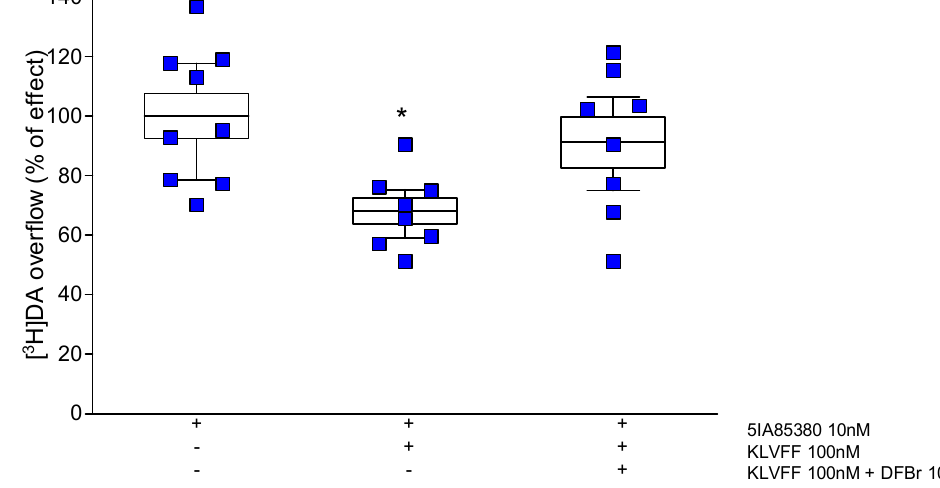
Figure 7. Effect of DFBr on the KLVFF modulation of 5IA85380-induced [ 3 H] dopamine overflow from striatal synaptosomes. Data are mean ± SEM ( n = 9 per group). * p < 0.05, (compared to 5IA85380) one-way ANOVA followed by Tukey’s post hoc test.